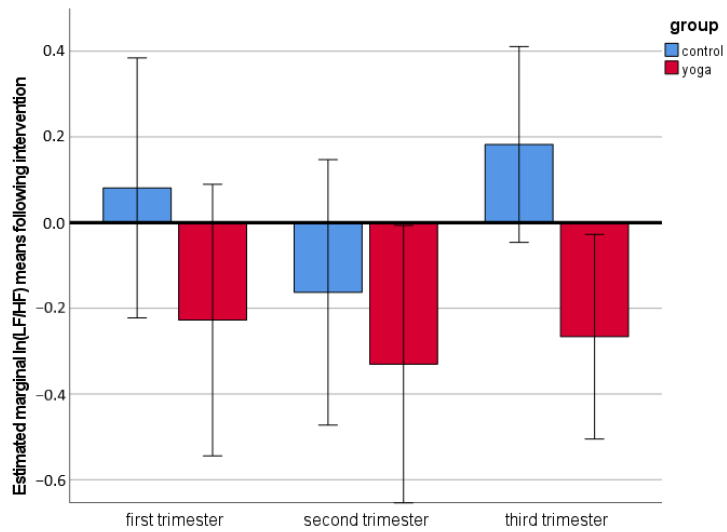
Figure 1. Estimated marginal means (with 95% confidence intervals) of the natural logarithm of low frequency (LF) to high frequency (HF) heart rate variability power ratio (ln(LF/HF)) following yoga and walking (control group) throughout all three trimesters of pregnancy. Note a significantly decreased ln(LF/HF) following yoga suggesting a more pronounced decrease in sympathetic to parasympathetic autonomic balance in the yoga group compared to controls (F(1,67) = 8.1, p = 0.006). Table 3. Blood pressure variables, respiratory frequency, and phase synchronization variables before vs. after yoga practice (yoga group) or walking (control group) throughout pregnancy.